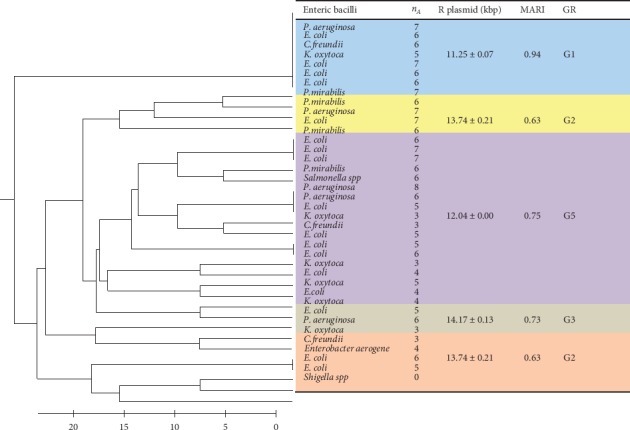
Resistance relatedness of enteric biotypes revealing different clusters of resistant phylogroups (GR, group of clustered resistant types; nA, number of resisted antibiotics; kbp, kilobase pair; MARI, multiantibiotic resistant index).